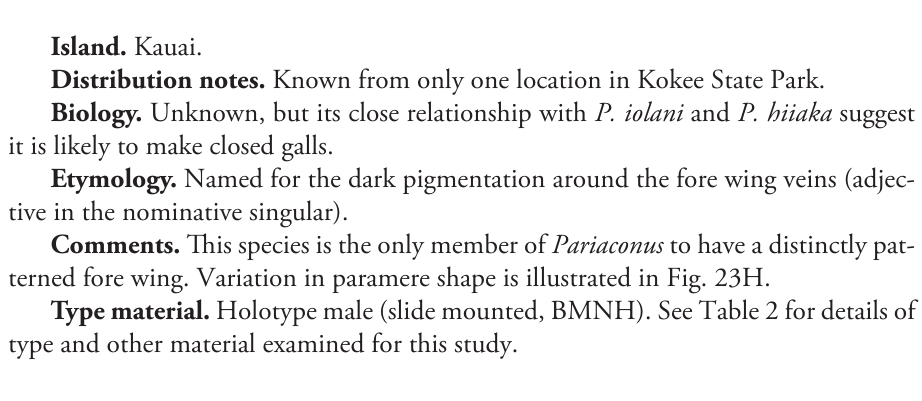
Adult colour. General body colour is either brown to yellow-brown, or green. Fore wing membrane clear. Adult structure. Fore wing apex rounded; surface spinules with limited distribu- tion in all cells except absent from r ; long setae on margins and medium long on veins 1 (Fig. 24A–B). Antennae long (av. length 1.48; ratio AL:HW av. 1.93); genal processes length short-medium, converging, and bluntly acute (ratio VL:GP av. 2.05); long setae on vertex and thorax; distal proboscis segment short (av. length 0.11); hind tibia thick, longer than head width (ratio HW:HT av. 0.86) (Fig. 24C, G–H). Male terminalia (Fig. 24D–F): paramere shorter than proctiger (ratio MP:PL 1.14), broad, more or less parallel-sided but broadening medially, and whole curving anteriorly from middle, apex moderately constricted with acute point directed anteriorly; distal aedeagus seg- ment length subequal to paramere (ratio PL:AEL 1.00) with base rounded and slightly inflated, and a large bluntly hooked apex (ratio AEL:AELH 2.14). Female terminalia (Fig. 24I–J): proctiger long, dorsal surface slightly medial depressed, apex bluntly acute, anal ring extremely short and on a raised collar (ratio FP:RL 8.70); subgenital plate with slight medial bulge ventrally and apex acute, length subequal to proctiger (ratio FP:FSP 1.01); ovipositor apex with distinct serrations (3 above, 2 below), valvulae dorsalis mod- erately convex